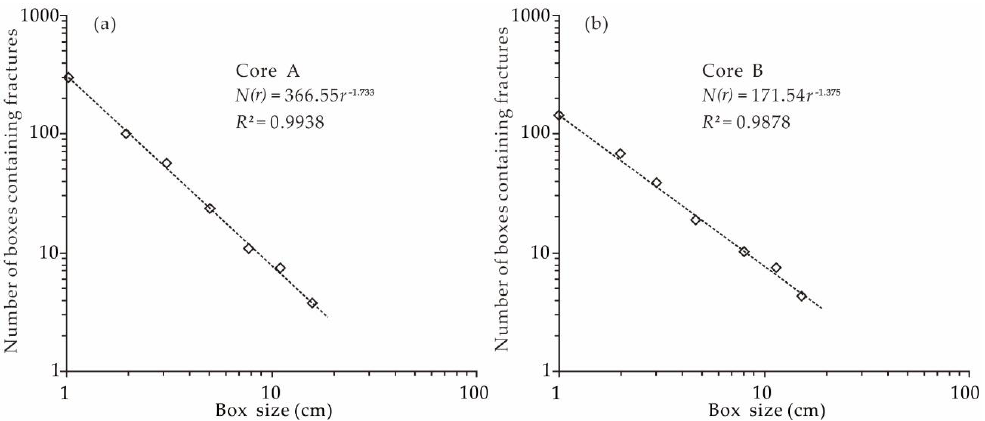
Figure 3. Schematic diagram for the calculation of fracture fractal dimension (modified from [59]). ( a ) Calculation of fracture fractal dimension for core A; ( b ) Calculation of fracture fractal dimension for core B.